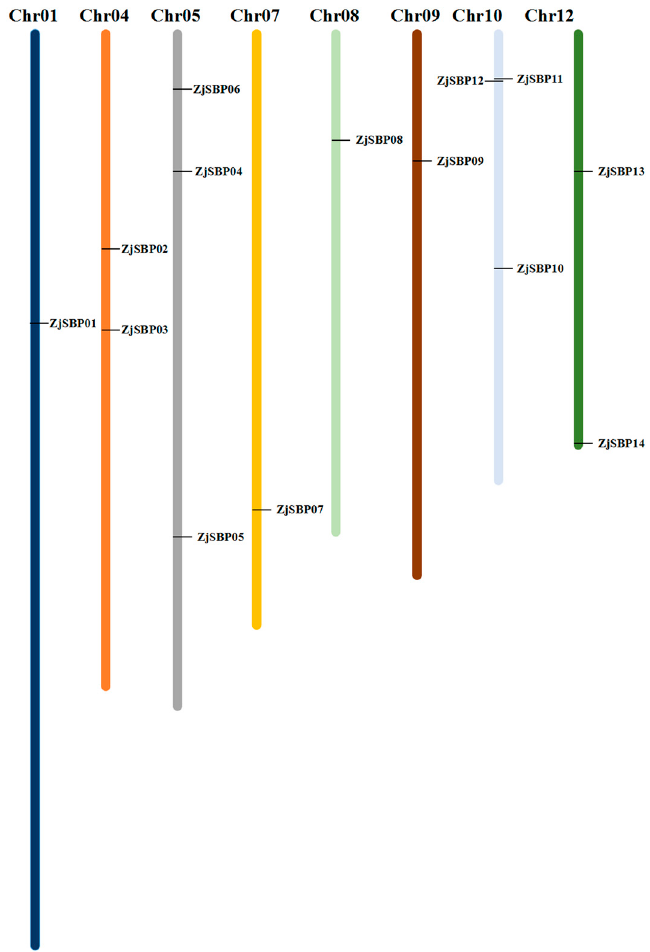
Figure 1. Distribution of ZjSBP genes over the jujube chromosomes.